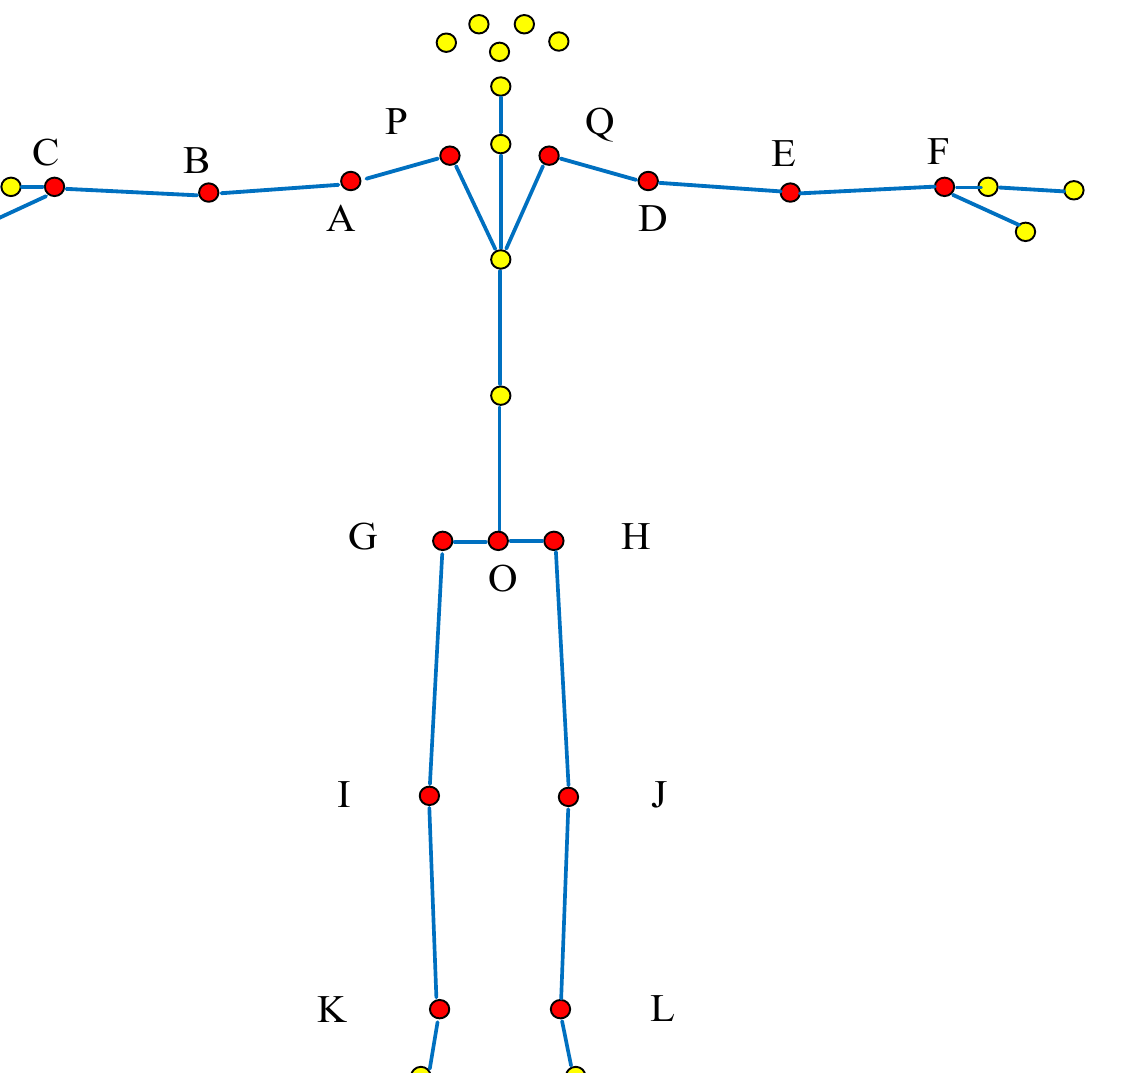
Figure 2. Select the overall joint point of the action (The red dot is the selected bone joint in this study, and yellow dot is bone joint point that do not need to be considered in this study. The letter is the code of selected bone joint corresponded to Table 1).